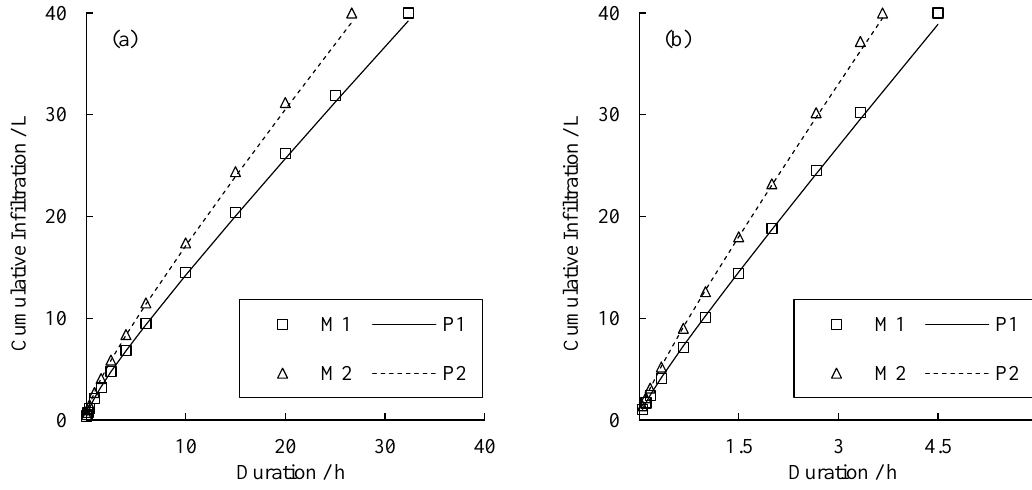
Figure 7. Comparison of measured data and model predictions. (a) Minqin sandy loam; and (b) Minqin aeolian sand. M1= measured value (D=4cm and L=25cm); P1= predicted value (D=4cm and L=25cm); M2= measured value (D=4cm and L=35cm); and P2= predicted value (D=4cm and L=35cm);